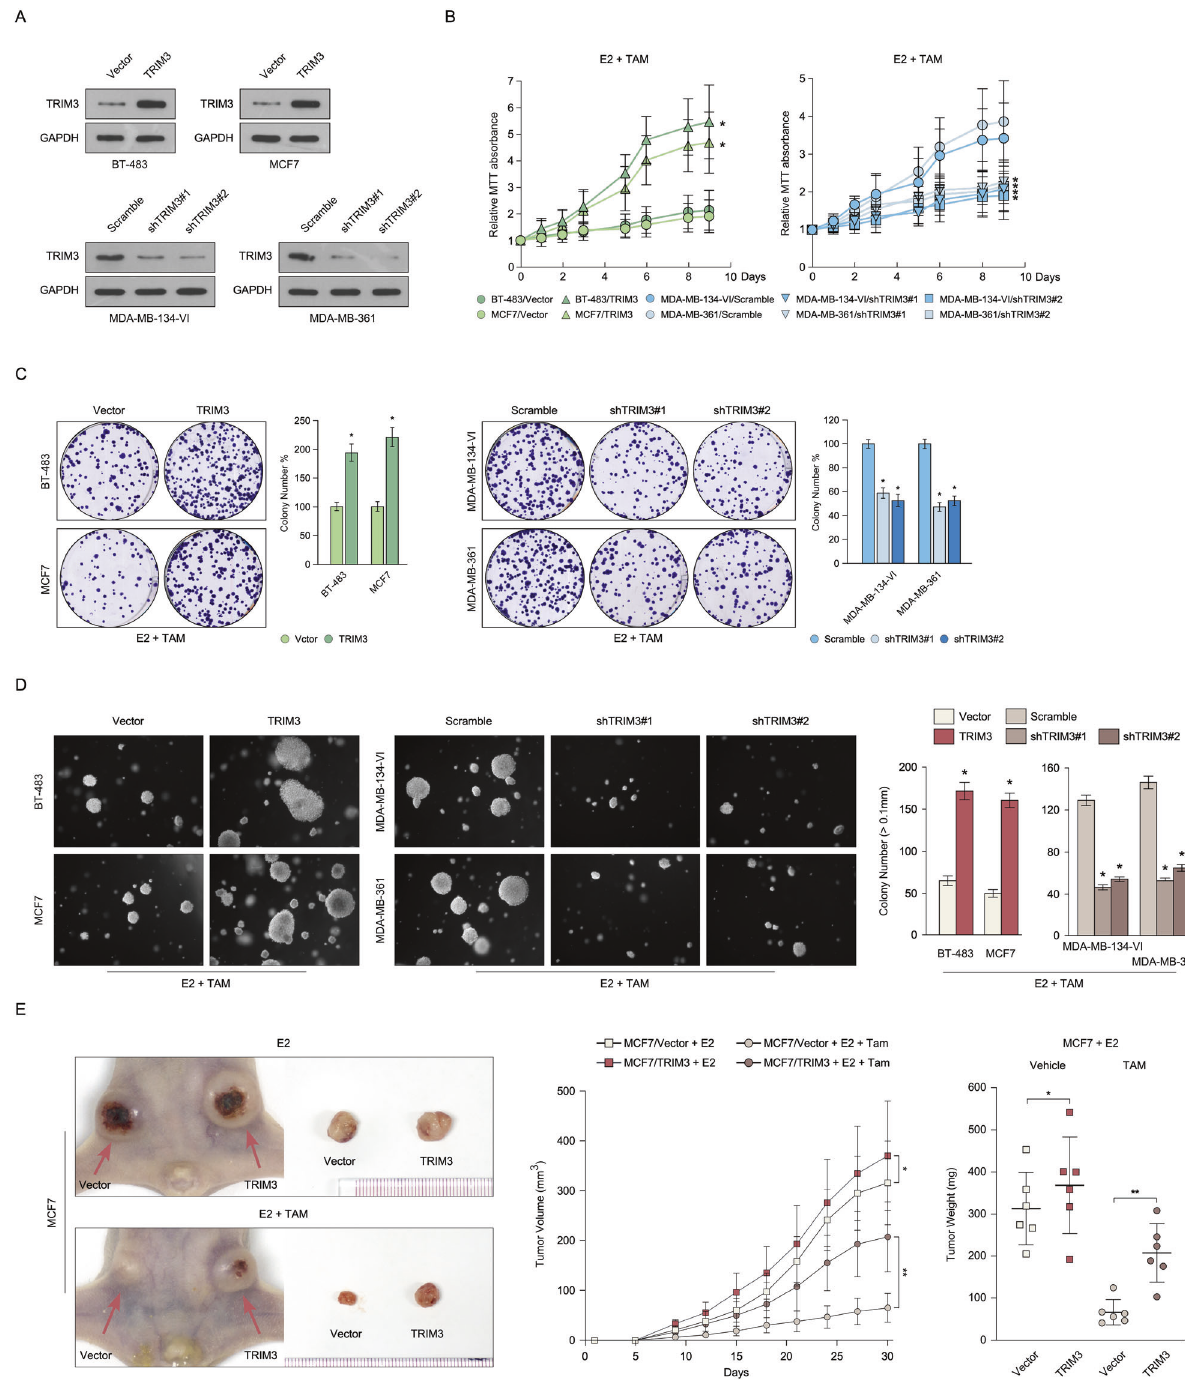
Fig. 2 TRIM3 contributes to tamoxifen resistance in breast cancer. A Western blotting analysis of TRIM3 levels in the indicated breast cancer cell lines stably overexpressing TRIM3 and silencing for TRIM3. Cell viability was measured using MTT ( B ) and colony formation ( C ) assays in the indicated cell lines treated with E2 (10 nM) and TAM (1 μ M). Statistical data are presented as the mean ± SD. D Soft agar assay of the indicated cells treated with E2 (10 nM) and TAM (1 μ M) (left panel) and the statistical signi fi cance of colony formation was assessed in the right panel. Data are presented as the mean ± SD. P < 0.05. E Representative images of the tumors in the xenografts (left panel). Tumor growth curves (middle panel) and tumor weight (right panel) of the indicated xenograft tumors ( n = 6/group). Data are presented as the mean ± SD. * P < 0.05, ** P <